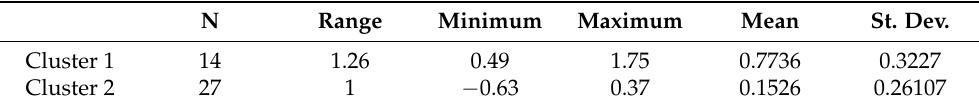
Table 3. Descriptive statistics.